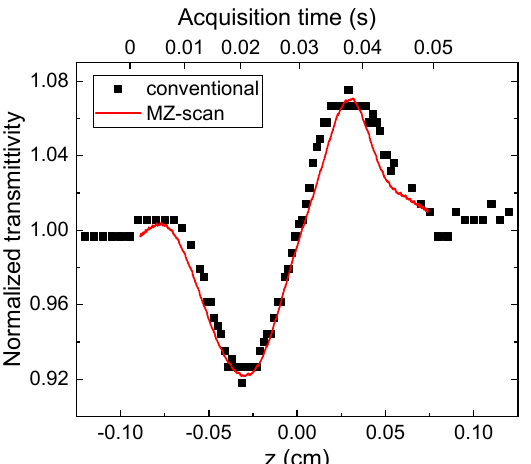
Figure 3. MZ-scan measurements of a reference CS 2 sample with probe beam energy equal to 3 nJ (red line). Conventional measurements obtained by linear translation of the sample used to cali- brate the actuator for the MZ-scan technique are also shown. Upper abscissa scale: time scale of the MZ-scan data; lower abscissa scale: Z position of the sample in conventional measurement. Since the sample position was sinusoidally driven, matching of the time-dependent MZ-scan with the conventional measurement was obtained using the equation z = Asin ( 2 π f × t + ϕ ) − δ , with A = 0.082 cm, f = 10 Hz, ϕ = 1.4 and δ = 0.008 cm, where A is the motion amplitude, f and ϕ are the position modulation frequency and phase, respectively, and δ is the sample rest